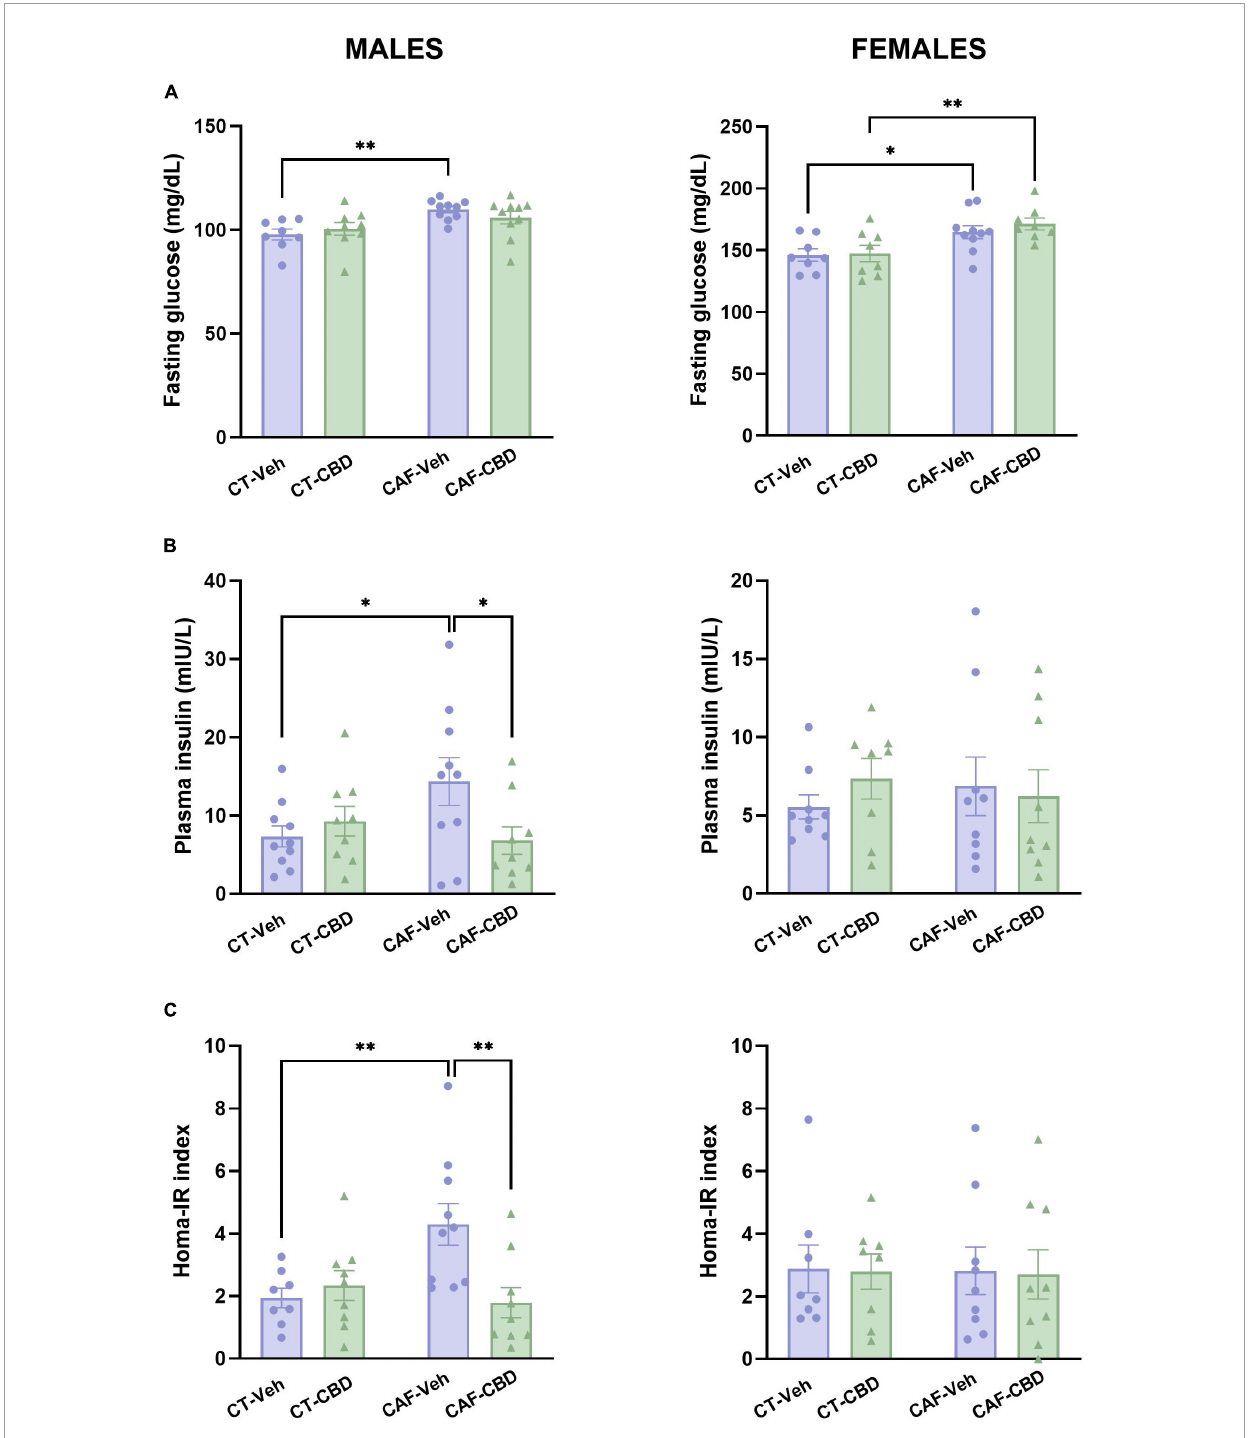
FIGURE5 Plasma levels of glucose and insulin and calculated homeostatic model assessment (HOMA-IR) index of the offspring. Maternal obesity increased fasting glucose levels in both male and female offspring with no cannabidiol (CBD) effect (A) . Maternal obesity increased levels of plasma insulin in males, but CBD treatment was able to revert this damage (B) . Male cafeteria (CAF)-vehicle (Veh) presented an elevated HOMA-IR index, which was alleviated by CBD treatment (C) . Data are presented as mean ± SEM. n = 8–10/group. ∗ p < 0.05 ∗∗∗ p <